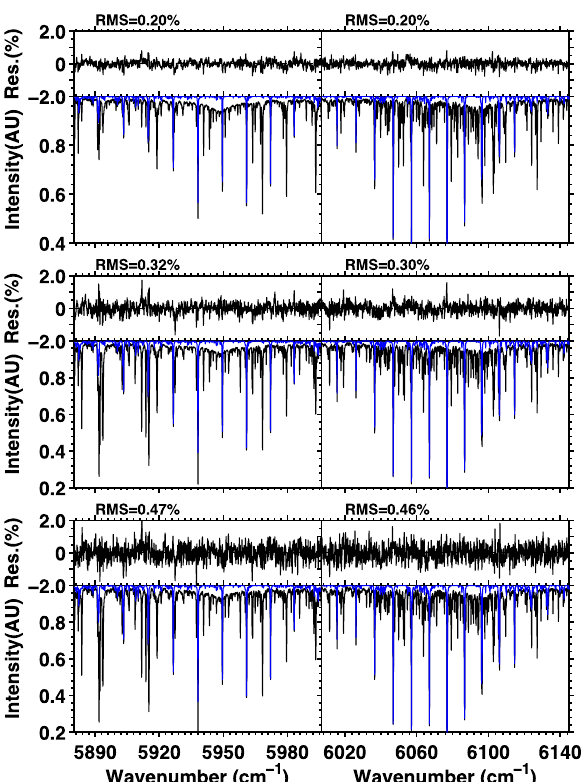
Figure 8 . Sample spectral fittings of CH 4 bands, which are centered at 5938 cm -1 (noted as MW5938 thereafter) and 6076 cm -1 (noted as MW6076 thereafter) using the CLARS-FTS measurements in the Spectralon viewing geometry (Top panels); pointing at the Santa Anita Race Track, Arcadia (middle panels); or pointing at the west Pasadena (Bottom panels). The measurements were taken on January 3 rd , 2013 with a Solar Zenith Angle (SZA) of 58.62º (top panels), 58.39º (middle panels), and 57.89º (bottom panels) respectively. Each spectrum is from 12 co-added scans, which were taken consecutively over 3 minutes. The spectral SNR are 532:1, 417:1, and 227:1 from top to bottom panels, respectively. The measured radiances subtracting the simulated spectra, which included contributions of all trace gases and solar lines, yield the spectral fitting residuals. In all panels, black curves are measured spectra and blue curves are the estimated contribution of CH 4 absorption from the spectral fittings. Contributions of other species in these spectral regions are not shown.